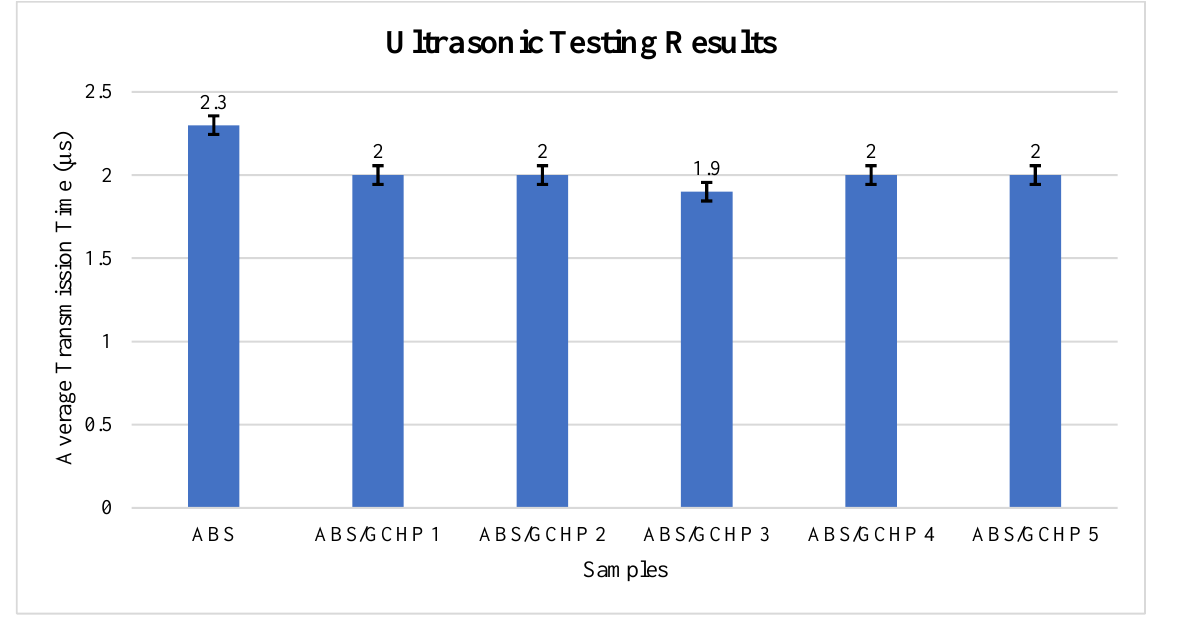
Figure 6. Ultrasonic testing results of ABS/GCHP composites with ABS. On the other hand, ABS/HCE composites showed a consistent transmission time, as shown in Figure 7. The 1- and 2-layered composites showed transmission time of 2.0 µs. The lowest transmission time of 1.9 µs was observed for 3- and 4-layered samples. ABS/HCE 5 samples showed a transmission time of 2.0 µs, which was lower than that of ABS (2.3 µs).